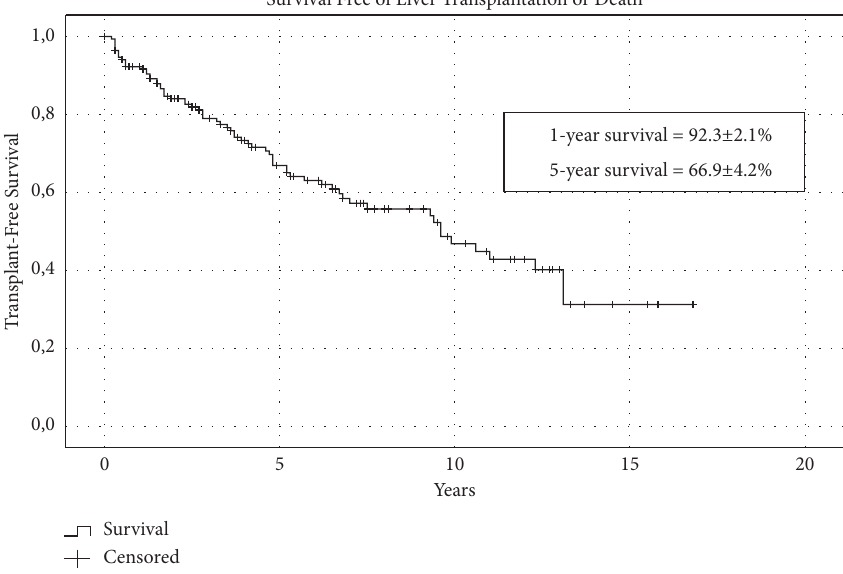
Figure 2: Kaplan–Meier curves of transplant-free survival of patients with PSC ( n �